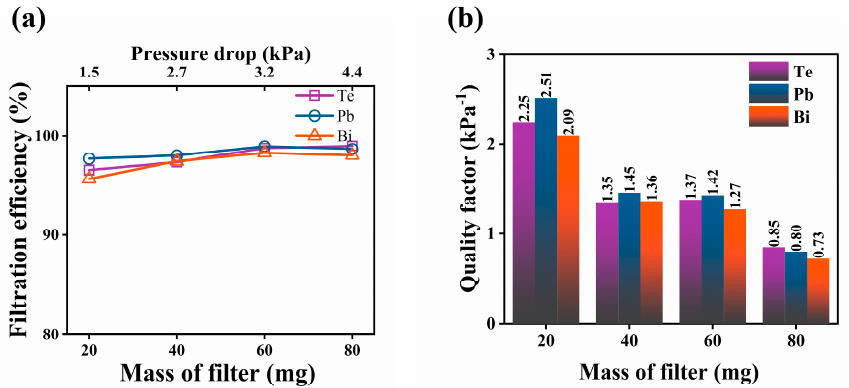
Figure 6. Comparisons of ( a ) filtration efficiency and ( b ) quality factor of the SiO 2 filtration mem- branes with different SiO 2 nanofiber loading levels for removing Te, Pb, and Bi at a filtration tempera- ture of 400 ◦